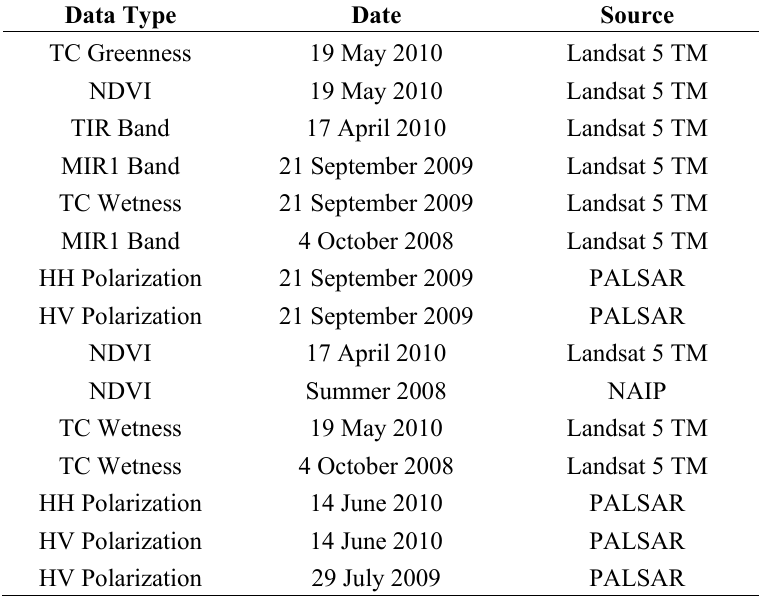
Table 11. Top 15 important variables, in order of importance, selected from the most accurate full season random forest model used in a RDL model for Level 2